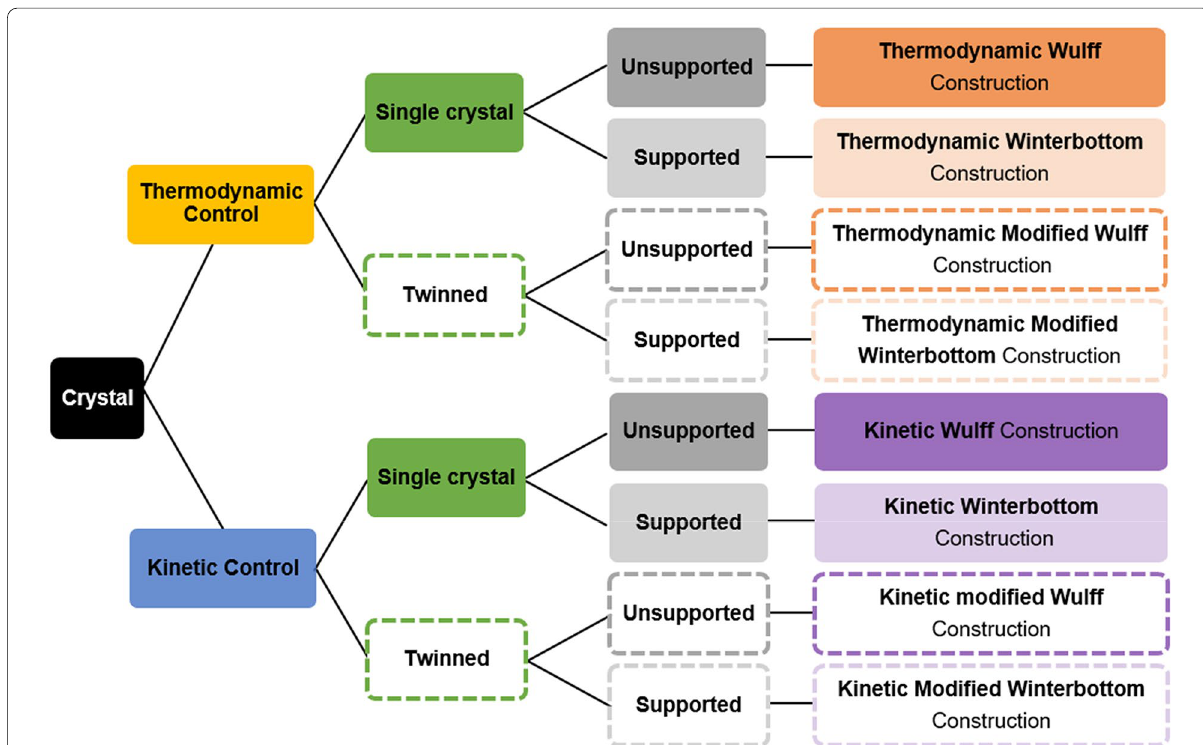
Fig. 6 Diagram of the terminology of the various shape constructions based on the considered surface property (energy for thermodynamic, growth velocity for kinetic), crystal structure (single or twinned crystal) and the growth environment (supported or